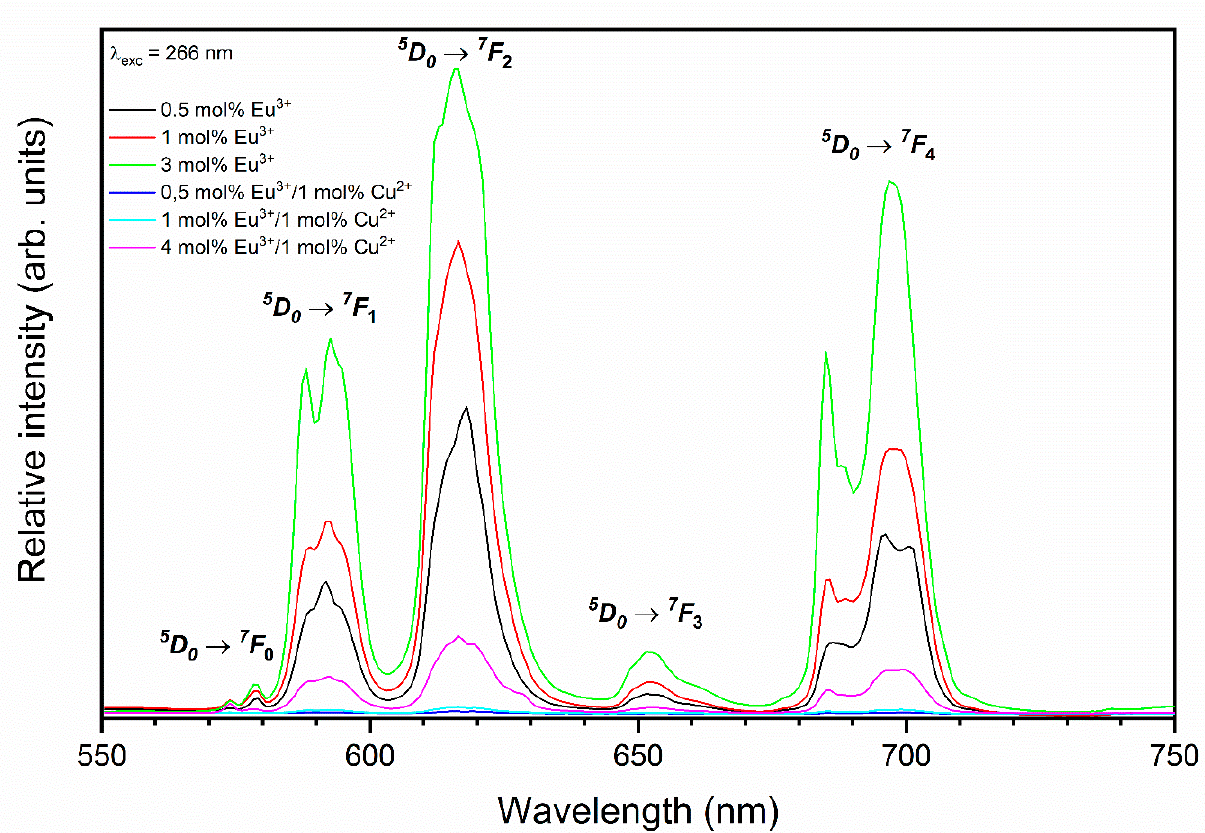
Figure 7. The emission spectra of the Eu 3+ -doped and Eu 3+ /Cu 2+ co-doped Ca 10 (PO 4 ) 6 (OH) 2 . In Figure 8, the time-resolved emission spectrum of the 1 mol% Eu 3+ /1 mol% Cu 2+ :HAp is